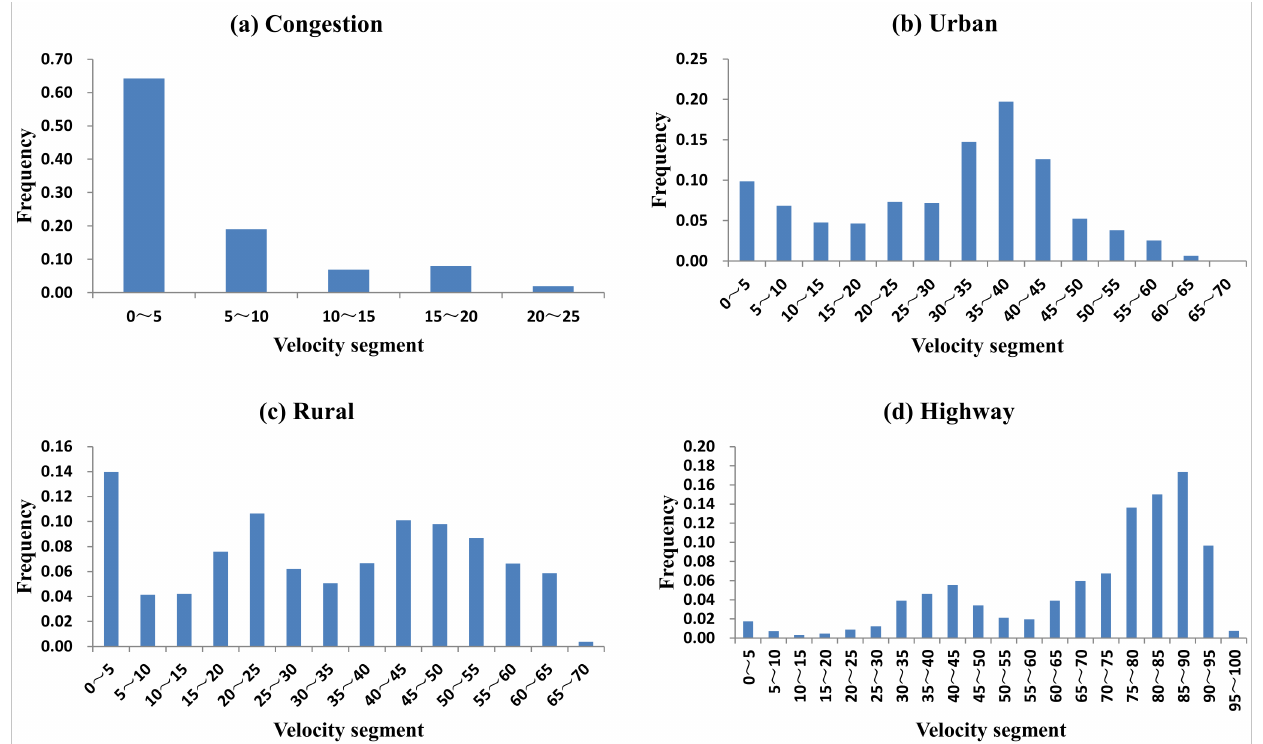
Figure 12. The distribution of speed frequent terms in congestion, urban, rural, and highway